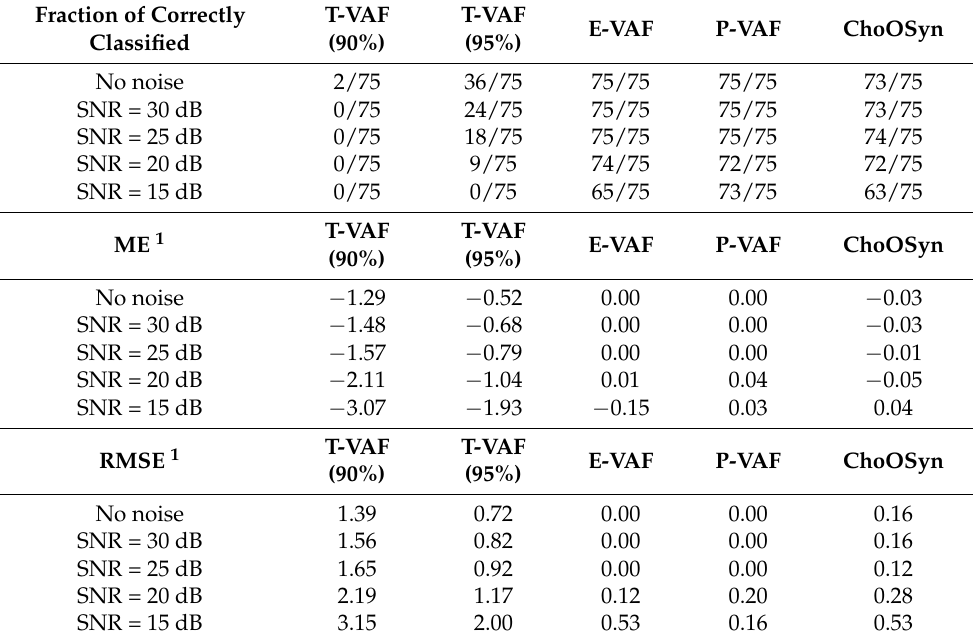
Table 1. Simulated dataset—performance of the different methods in terms of the fraction of correctly classified, mean error (ME), and root-mean-squared error